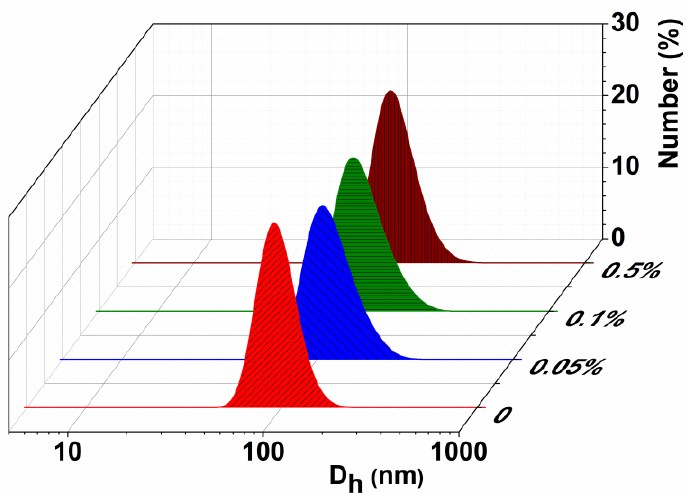
Figure 2. Number-averaged size distribution of the F1, at different Cs concentrations, 25 ° С.